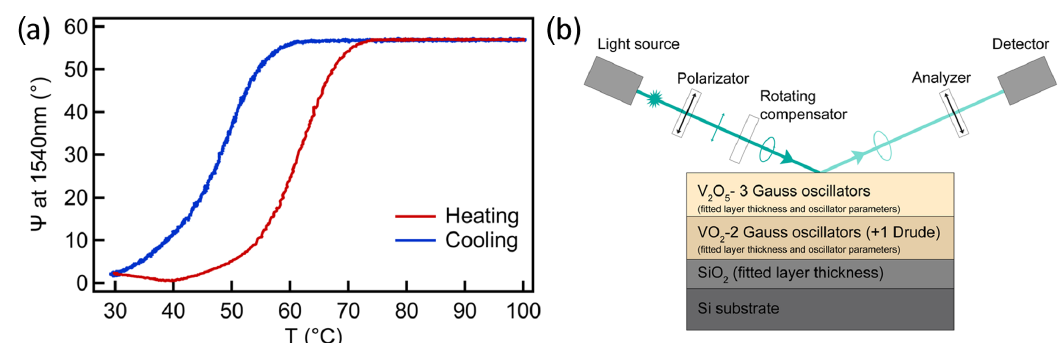
Figure 4. ( a ) Temperature dependent variation of Ψ during the heating cycle at the wavelength of 1540 nm wavelength in the infrared range. ( b ) Schematic of the applied optical model and the SE measurement